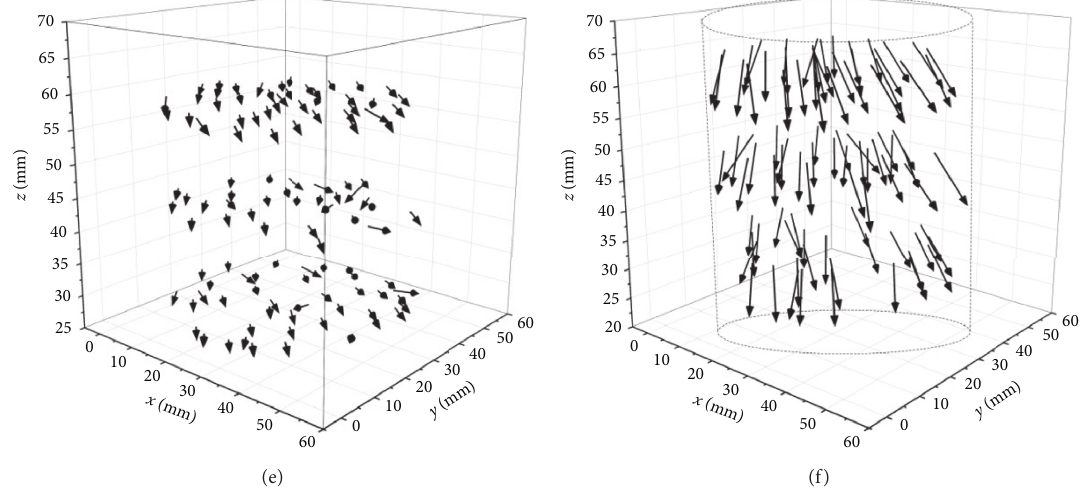
Figure 9: 3D displacement vectors of rock blocks during compression. (a) Axial strain: 0% to 1.480%. (b) Axial strain:1.480% to 3.083%. (c) Axial strain: 3.083% to 4.012%. (d) Axial strain: 4.012% to 6.012%. (e) Axial strain: 6.012% to 8.032%. (f) Axial strain: 0% to